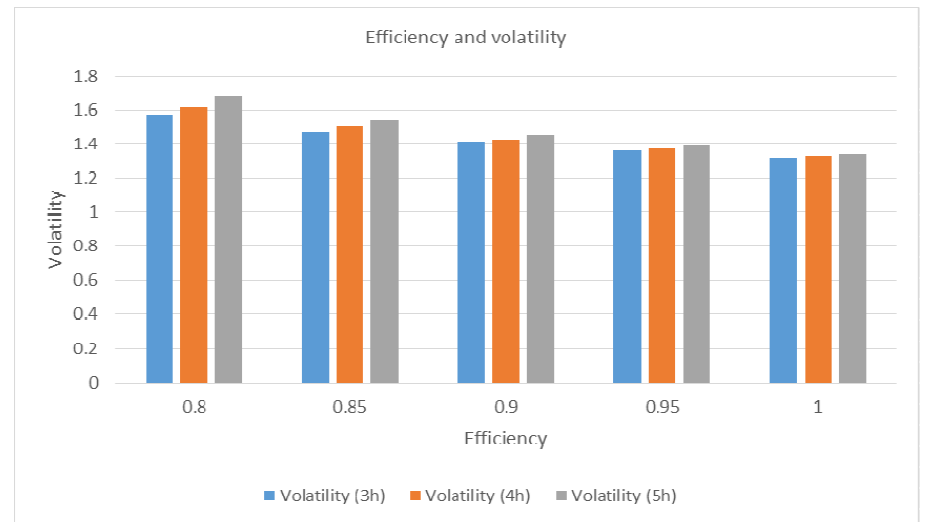
Figure 3. Efficiency and volatility for different operation